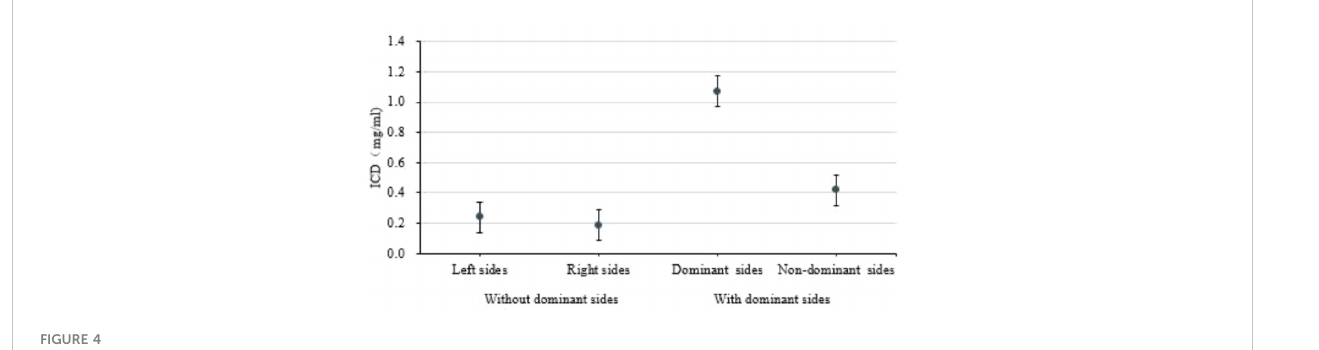
FIGURE 4 Comparions on both sides in patients with and without dominant